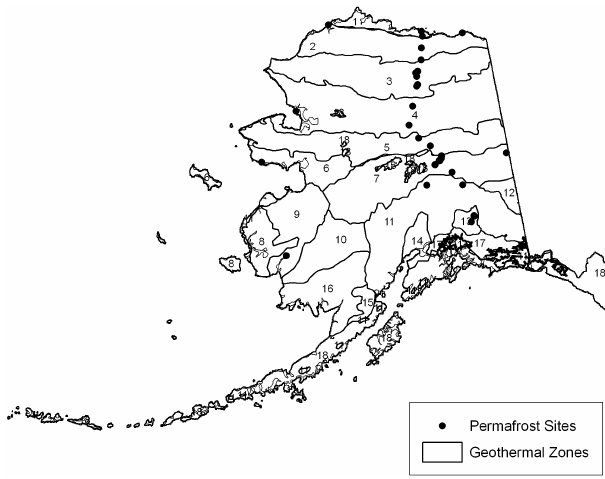
Fig. 1. Permafrost observation station locations and 18 ground tem- perature zones. Each ground temperature zone corresponds to its own initial ground temperature distribution